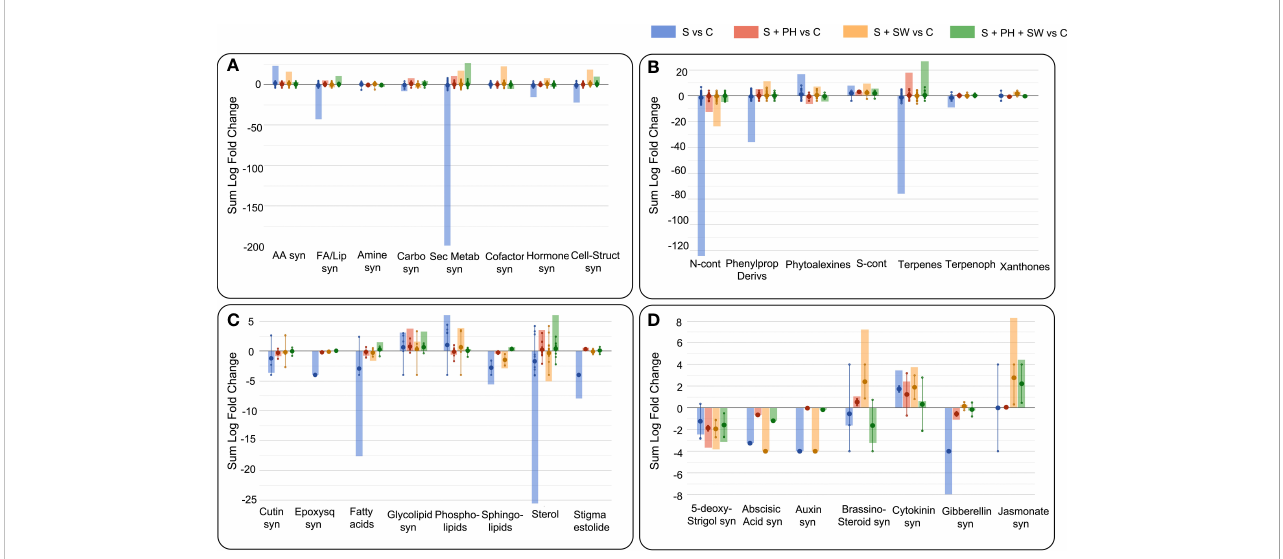
FIGURE 3 Pathway analysis of tomato leaves affected by salinity stress (S) and treated with biostimulants i.e., protein hydrolysate (PH), seaweed extracts (SW), and their combination PH + SW, compared to the control non-stressed plants (C) . The metabolites used to carry out the pathways analysis are those that have passed ANOVA (p-value< 0.05) and fold change (FC ≥ 2.5) analysis. Differential metabolites were interpreted in terms of biosynthesis pathways (A) , secondary metabolite (B) , lipids and fatty acids (C) and hormone biosynthesis ( D ). Error bars indicate the standard deviation of logFC values of all compounds belonging to the class. The larger dot indicates the median value, while the smaller dot indicates the actual value of each individual compound belonging to the class. The bars indicate the algebraic sum of the logFC values of the individual compounds belonging to the same class. Abbreviation = syn: biosynthesis; AA: amino acid; FA/Lip: fatty acid and lipid; Carbo: carbohydrate; Sec Metab: secondary metabolites; Cell-struct: cell-structure; N-cont: nitrogen-containing; Phenylprop: phenylpropanoids; S-cont: sulphur-containing; Terpenoph: terpenophenolics; Epoxysq: